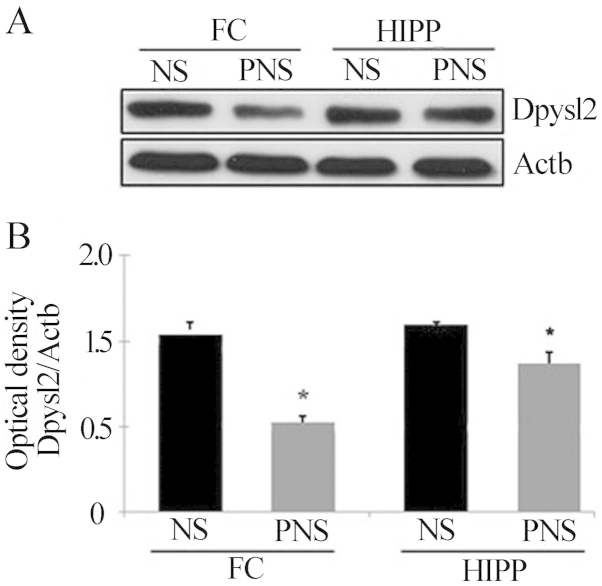
Western blot analysis of Dpysl2 expression in the brains of PNS-induced rats. (A) Dpysl2 expression was detected by western blotting with Actb used as an internal control. PNS rats exhibited decreased Dpysl2 expression in the prefrontal cortex and hippocampus. (B) Quantitative analysis of western blot data for Dpysl2 expression showing a significant difference in Dpysl2 levels in PNS vs. control rat brains (*P<0.05 compared with the NS group in the prefrontal cortex and hippocampus). Dpysl2, dihydropyrimidinase-like 2; FC, prefrontal cortex; Hipp, hippocampus; NS, non-prenatal stressed offspring; PNS, prenatal stressed offspring; SD, standard deviation.